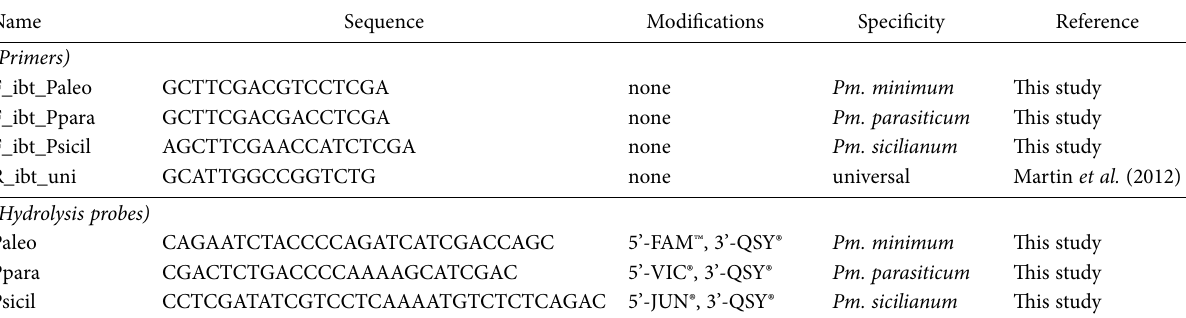
Table 2. Primers and hydrolysis probes used in this study. Oligonucleotide modifications and template specificity are